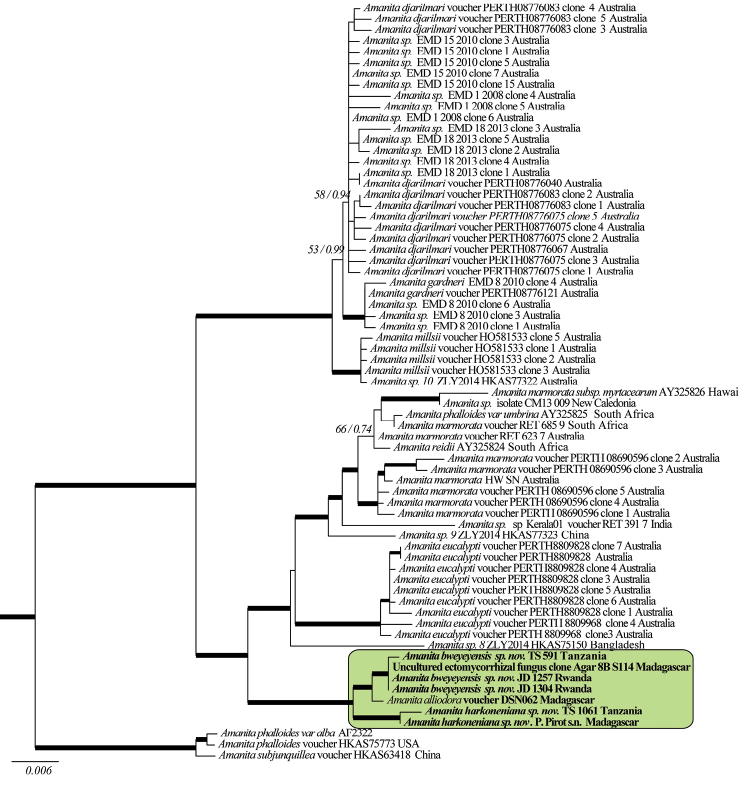
The 50% majority-rule consensus tree from Bayesian inference of the combined nuclear ITS-5.8S and LSU sequences. Thickened branches in bold indicate bootstrap support greater than 70% and Bayesian posterior probability greater than 0.95. For selected nodes, parsimony bootstrap support value and Bayesian posterior probabilities are, respectively, indicated to the left and right of slashes. The new taxa are highlighted in the shaded box.